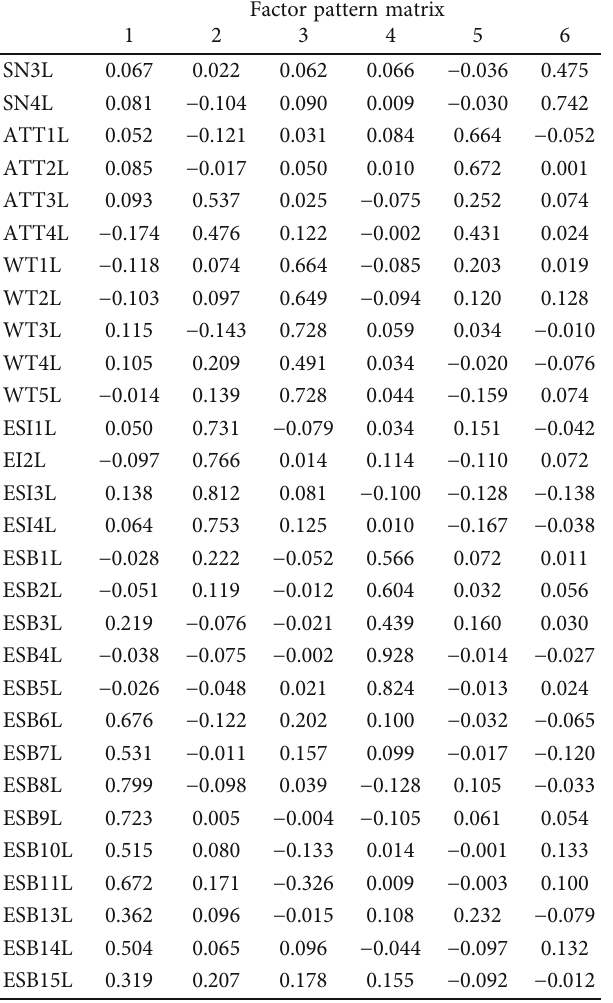
Table 6: Factor pattern matrix.